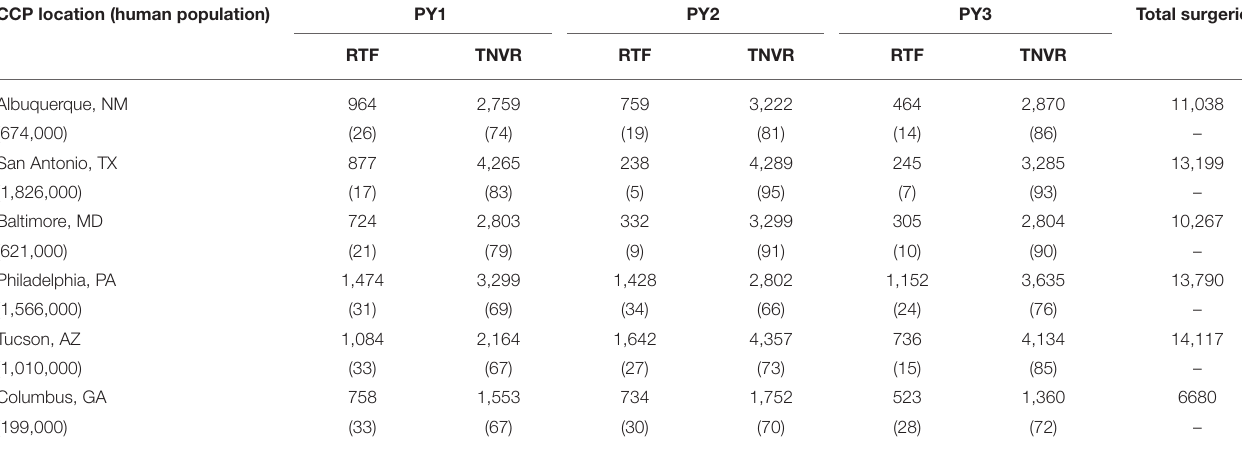
TABLE 2 | Number of RTF and TNVR surgeries performed annually in each of six 3-year CCPs and percentage of surgery total (in parentheses). CCP location (human population)